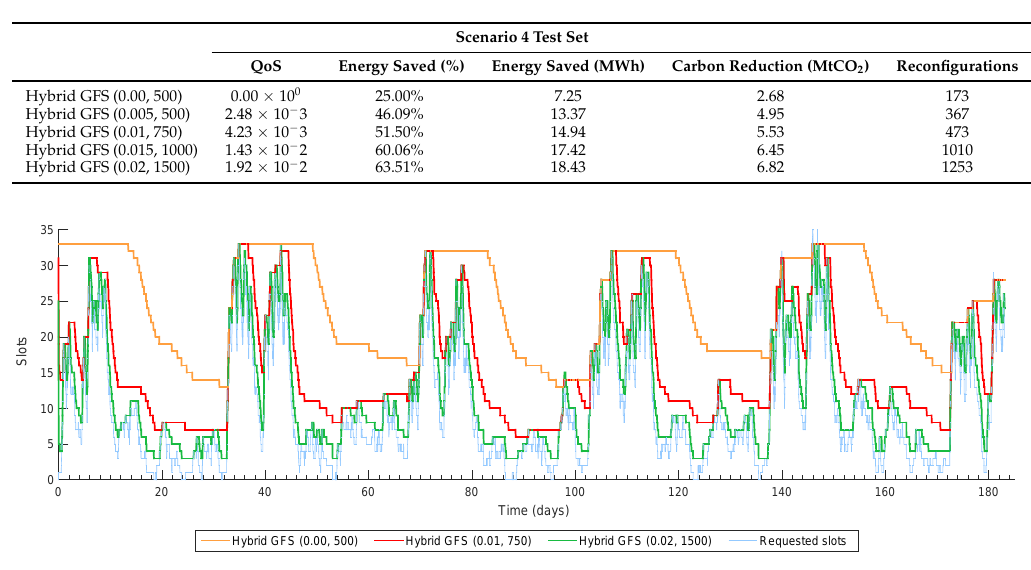
Figure 6. Cluster simulation trace for the test set of scenario 3. Table 5. Experiment results for the test set of scenario 4.